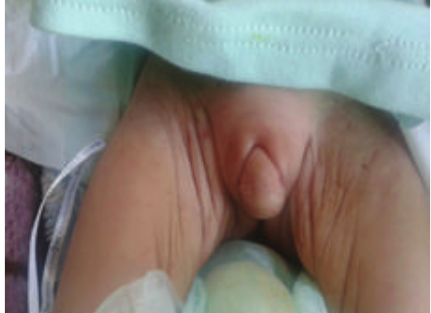
Figure 1: Case 1: testis ectopia, micropenis.